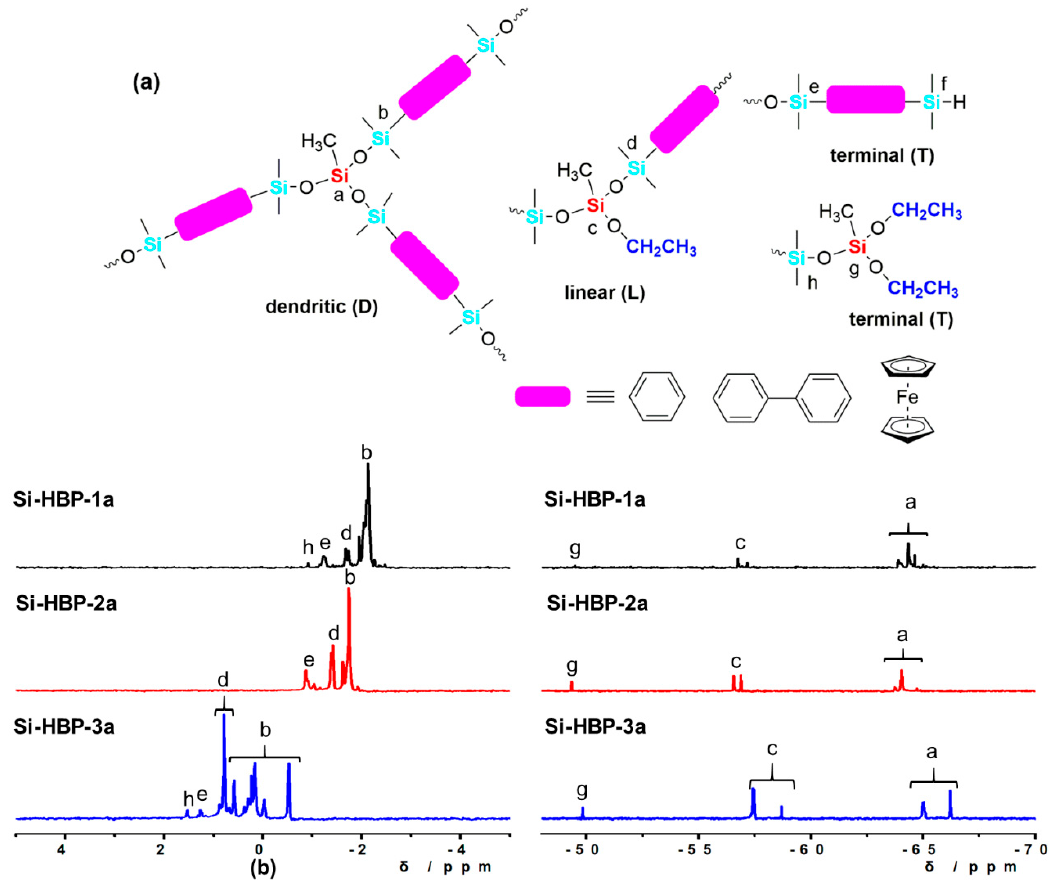
Figure 4. ( a ) The possible Si chemical environments for Si-HBPs; ( b – c ) 29 Si NMR spectra of Si-HBP-1a, Si-HBP-2a and Si-HBP-3a in the region of 5– − 5 ppm ( b ) and in the region of − 48– − 70 ppm ( c ).